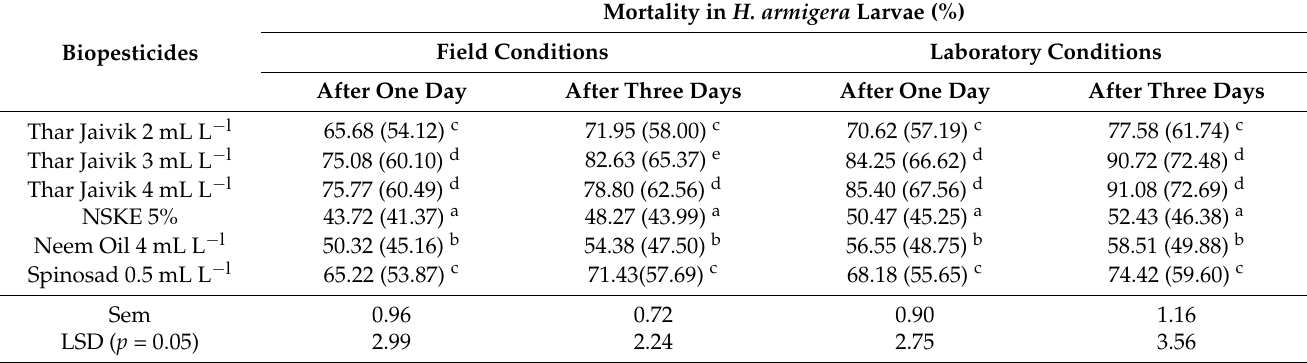
Table 2. Bio-efficacy of “Thar Jaivik 41 EC” and other biopesticides used at different concentrations against H. armigera on cucurbits (pooled data, 2018 and 2019).